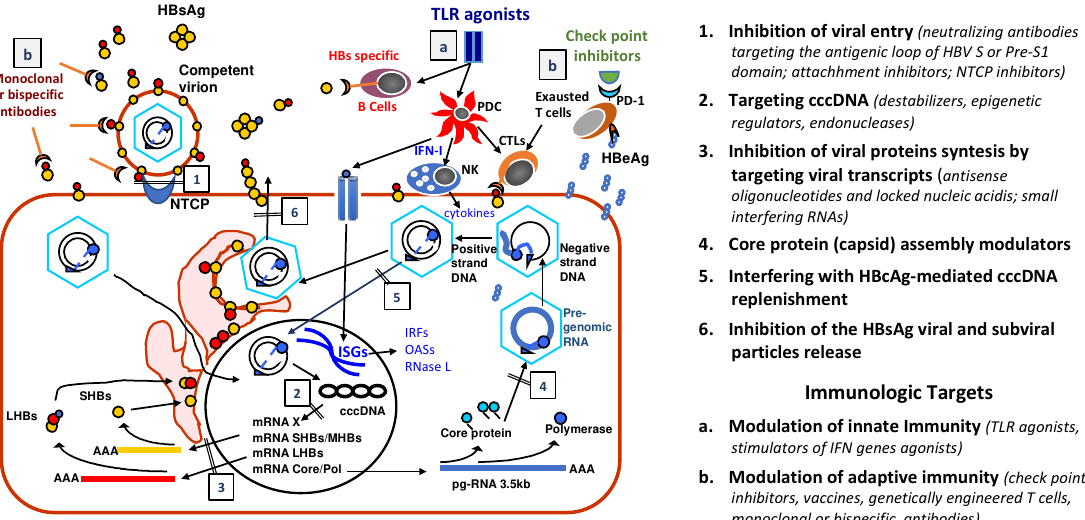
Figure 1. HBV replicative cycle and targets of the drugs under development to cure chronic hepatitis B patients. Description of their mode of action at the different steps of the HBV cycle or according to their modulation of immune response: (1) inhibition of viral entry by Na-Taurocholate Cotransporting Polypeptide (NTCP) receptor inhibitors or by neutralizing antibodies targeting the Pre-S1 domain of the HBsAg (b); (2) destabilization/degradation of the nuclear covalently closed circular DNA (cccDNA) or inhibition of its transcription; (3) inhibition of viral proteins synthesis by targeting viral mRNAs coding for HBx, small, middle and large (S, M and L) HBs, Core and Polymerase (Pol) proteins; (4) interference with Core protein assembly and (5) HBcAg-mediated cccDNA replenishment; (6) inhibition of viral and subviral particles HBsAg release; (a) modulation of innate immunity by Toll Like Receptors (TLR) agonists, which can activate Plasmacytoid Dendritic Cells (PDC), Natural Killer (NK) cells, or Interferon (IFN) Sensitive Genes (ISGs) response, which increase the production of several IFN Response Factors (IRFs) with broad-spectrum antiviral activity, similar to that of 2 (cid:48) -5 (cid:48) -oligoadenylate synthetase (OASs) and RNase L; (b) modulation of the adaptive immunity, by check point inhibitors acting on the Programmed Death 1 (PD-1) receptor of viral antigen-specific T cells exhausted because of the antigen overload, thus improving Cytotoxic T Lymphocytes (CTL) activity. Alternative approaches to increase recognition and elimination of HBV infected cells include genetically engineered T cells and therapeutic